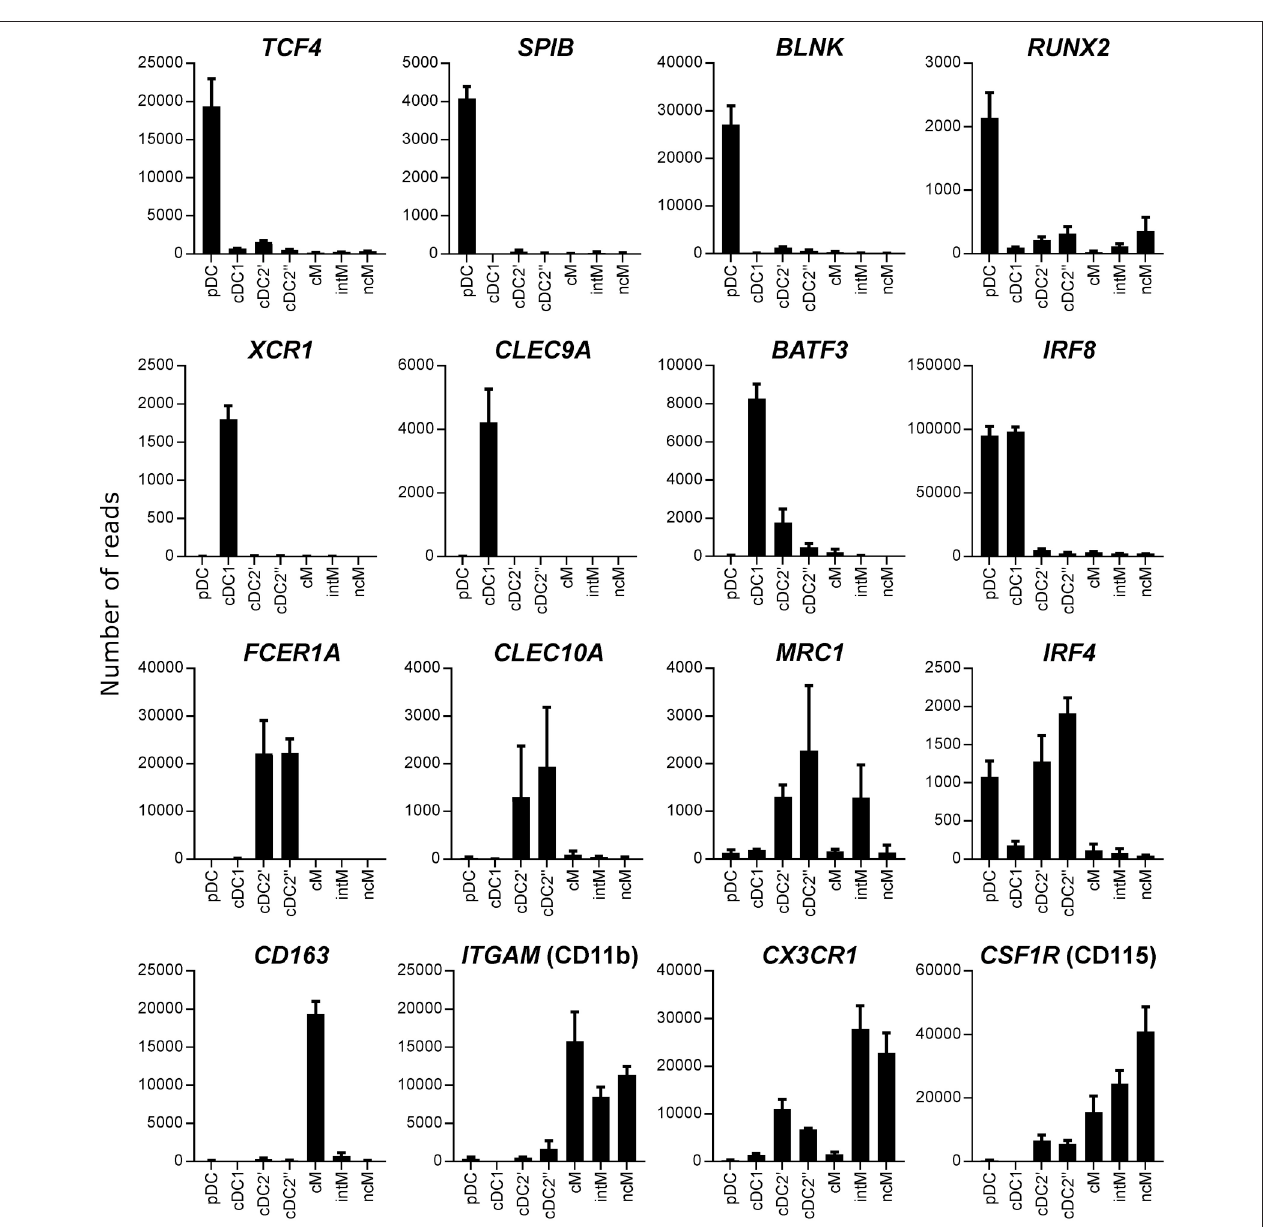
FIGURE 3 | Transcription of key genes. High-throughput sequencing was performed on RNA isolated from sorted DC and monocyte subsets. Mean number of normalized reads and SD is shown for three animals and selected key genes.